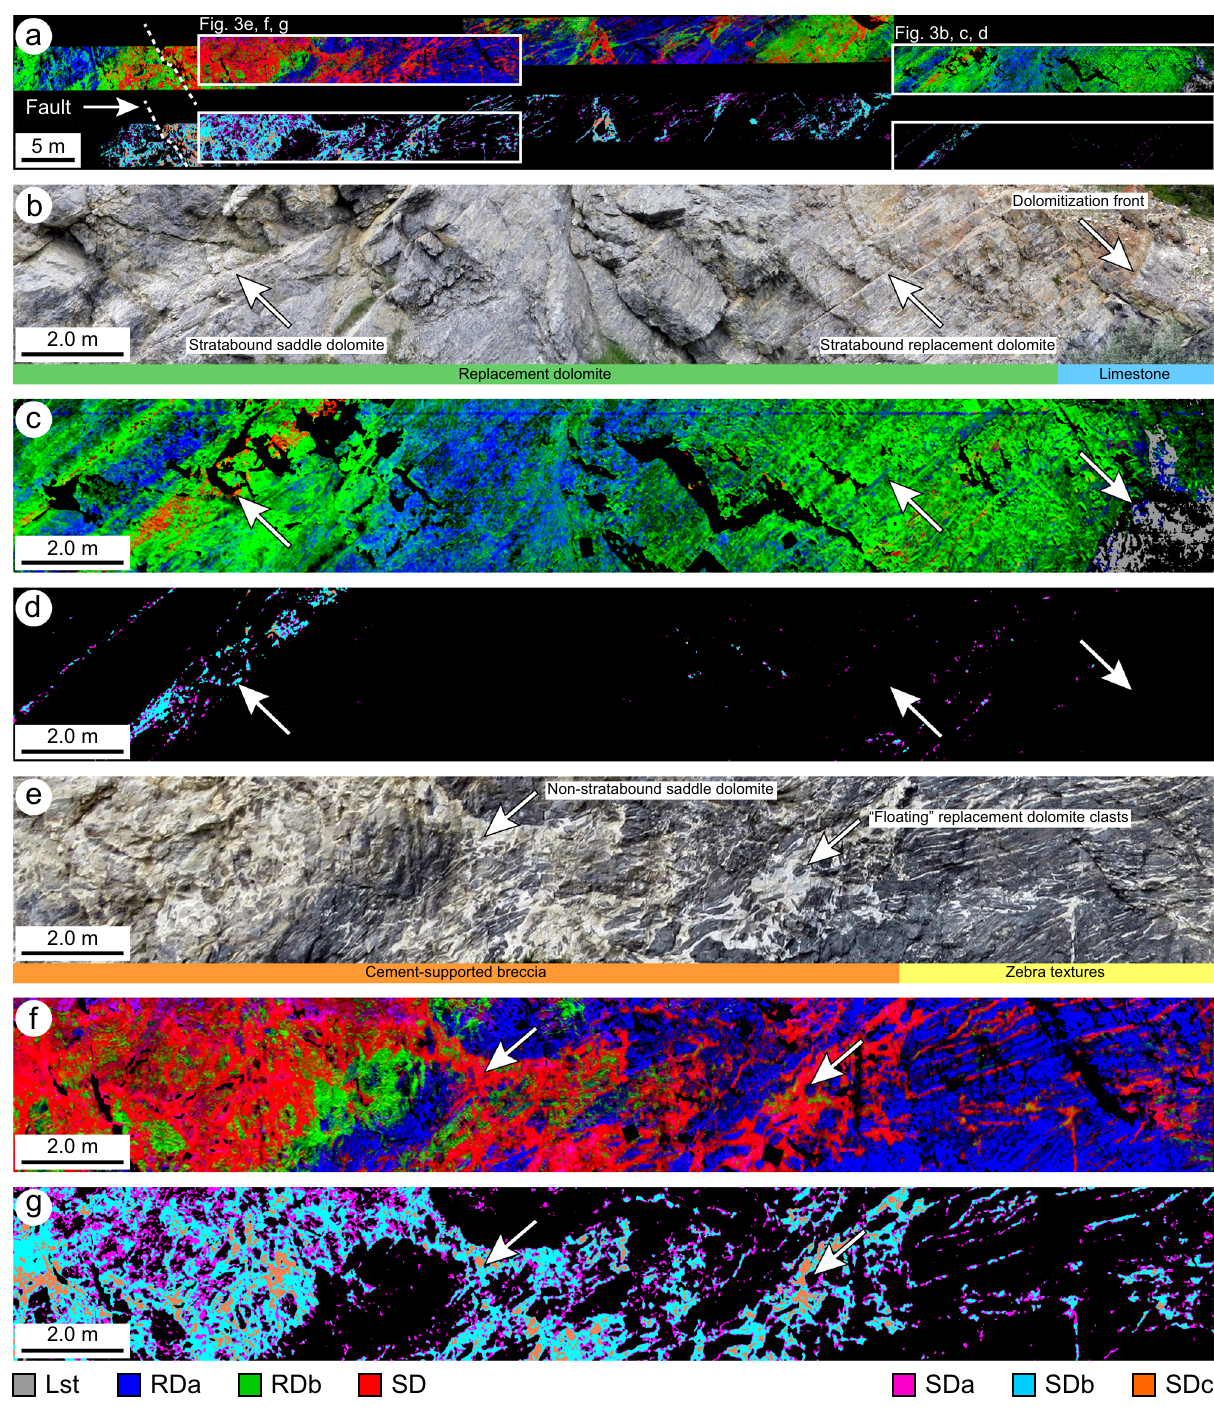
Figure 3. Endmember mineral distribution maps of the Cathedral Formation at Whirlpool Point showing ( a ) an overview of the acquired imagery illustrating the spatial distributions of each diagenetic phase (upper panels show Lst, RDa, RDb, and SD; lower panels show SDa, SDb, and SDc). Lst was mapped by retaining all pixels with a carbonate absorption-band position > 2330 nm. ( b ) The distal part of the fault-controlled dolomite body (white box in a ) showing the abundant stratabound dolomite at the dolomitization front (limestone-dolomite contact) accompanied by ( c ) the corresponding Lst, RDa, RDb, and SD mineral distribution map, as well as ( d ) the SDa, SDb, and SDc mineral distribution map. ( e ) The proximal part of the fault-controlled dolomite body (white box in a ) showing the abundant non-stratabound dolomite, cement-supported breccias, and zebra textures accompanied by ( f ) the corresponding Lst, RDa, RDb, and SD mineral map, as well as ( g ) the SDa, SDb, and SDc mineral map. Original, full-resolution, images are available in supplementary